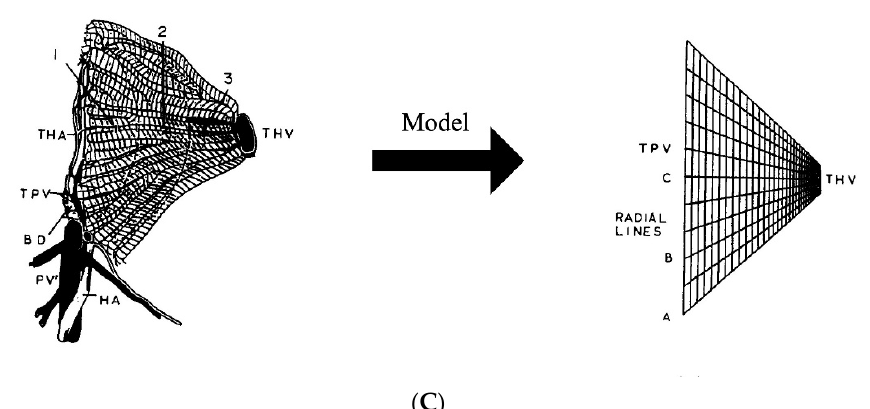
Figure 2. ( A ) Liver physiology describing the liver acinus comprising the portal triad (portal vein, hepatic artery, and bile duct), sinusoids flanked by hepatocytes and fenesterated endothelial cells, and the draining central vein [54,55]. Figure reprinted with permission from [54] cited in text. ( B ) Based on the distance from the portal triad, the acinus is divided into three zones that are characterized by different permeabilities and metabolic functions in the hepatocytes due to the difference in oxygenation level [56] ( C ). 2D-finite element modeling of liver perfusion based on the liver acinus structure and fluid flow and mass transfer based on porous media theory. PV—portal vein, HA—hepatic artery, BD—bile duct, TPV—terminal portal venule, THA—terminal hepatic arteriole. 1, 2, and 3 indicate different zones in the acinus. The longer edge in the finite element grid represents the TPV, and the shorter edge represents a THV [74]. Figure reprinted with permission from [74] cited in text.